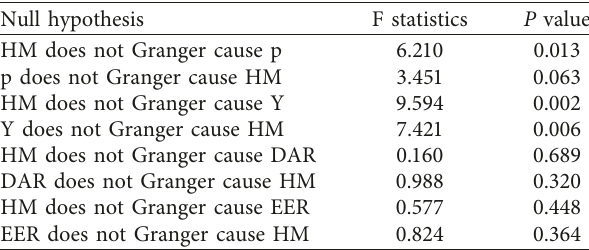
Table 4: Granger causality